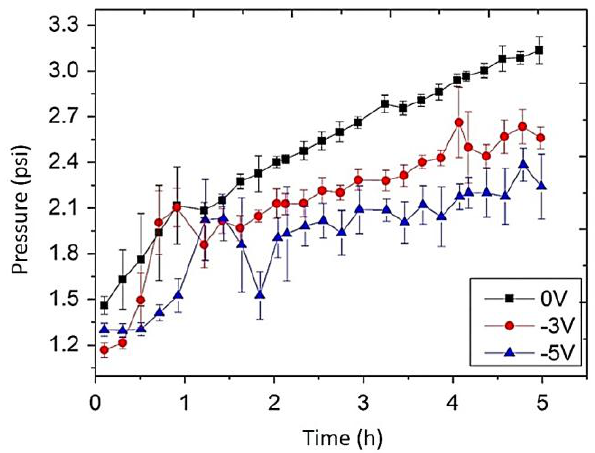
Figure 9. Impact of applied electrical potential on transmembrane pressure. Reprinted from [127], with permission from Elsevier.